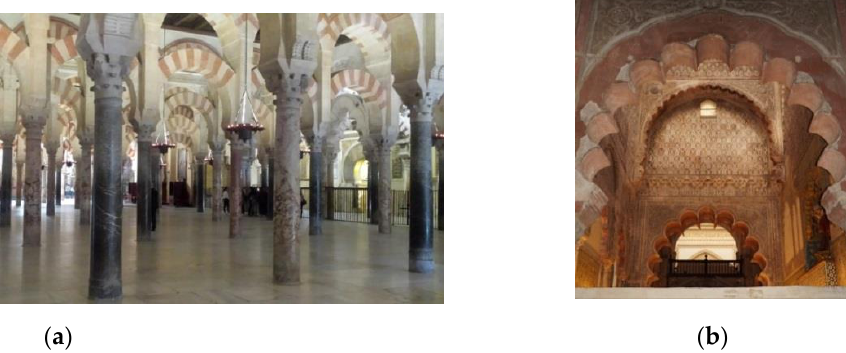
Figure 3. Inner view: ( a ) columns forest and ( b ) Royal Chapel. Source: Own photographs.